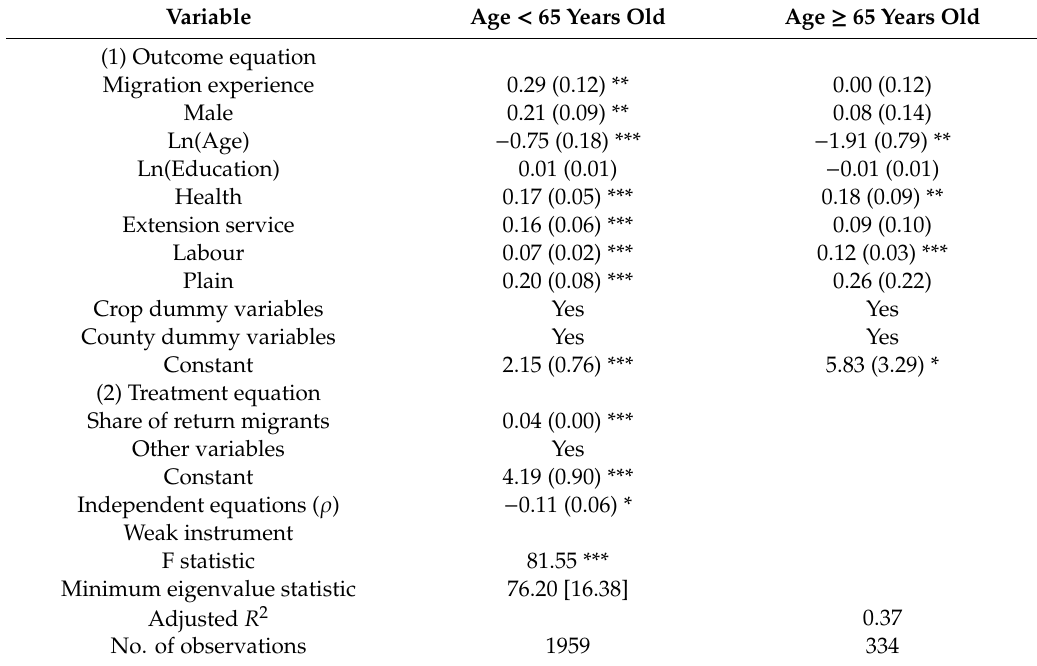
Table 5. The e ff ects of rural–urban migration experience on arable land use by age